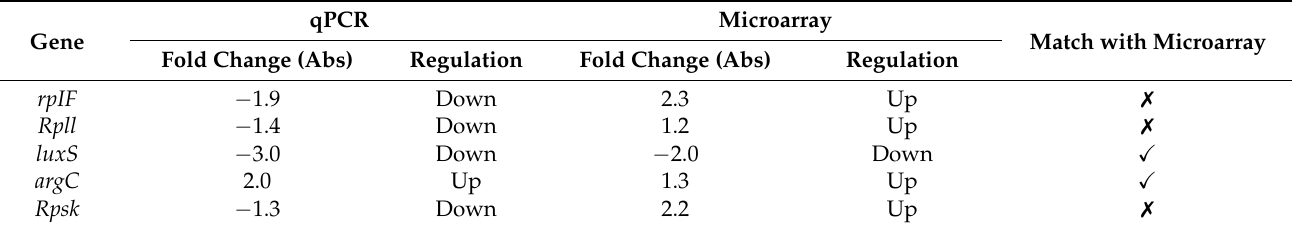
Table 4. A comparison between microarray and qPCR results for E (eugenol) versus C (control) for the genes, rpIF , rplI , luxS , argC , and rpsK , using the gmk gene for normalisation.